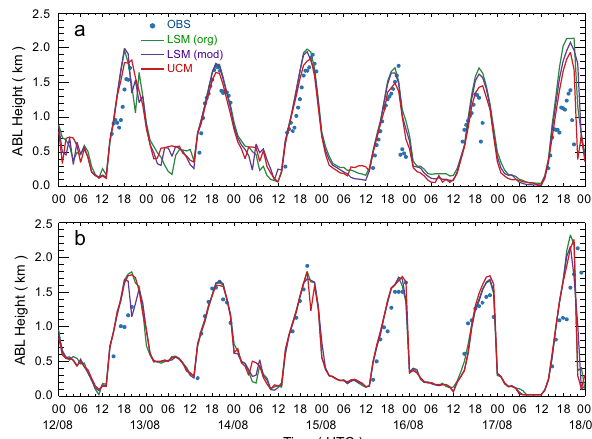
Fig. 12. Diurnal variations of the observed and simulated ABL heights at (a) the La Porte site and (b) the Arcola site from 12 Au- gust to 17